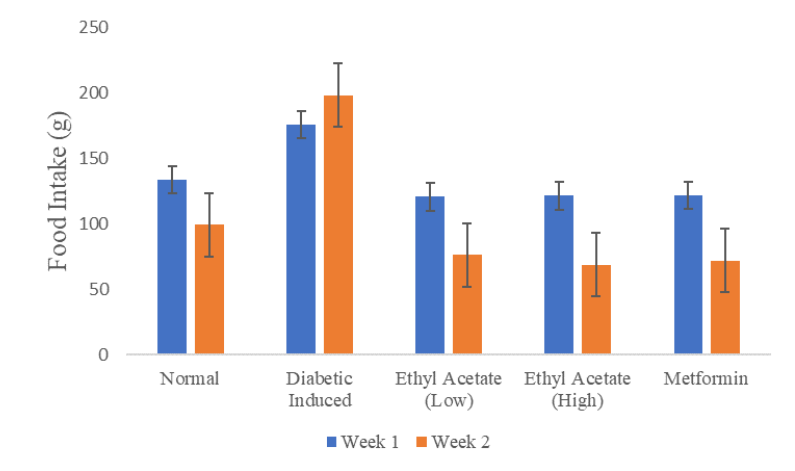
Figure 2. Food intake of animals during the 14 days of